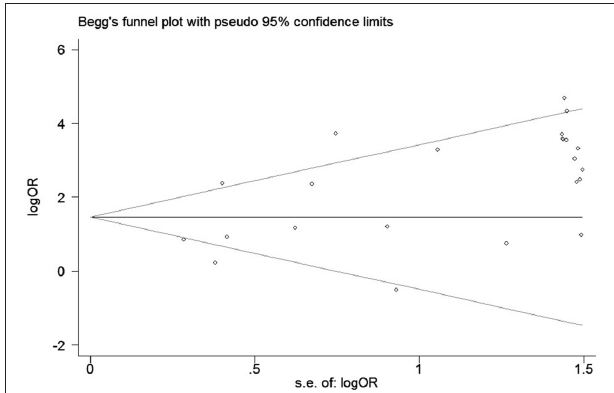
FIGURE 9 | Funnel plot for evaluating the association of hMLH1 methylation with gastric cancer risk. Each circle represents one specific study.